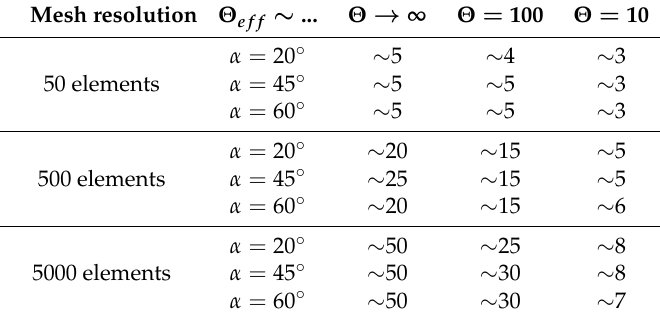
Table 1. Effective diffusion coefficient ratio ( Θ ef f ) for different mesh resolutions, alignment of the magnetic field ( α ) and diffusion coefficient ratios ( Θ ). Mesh resolution Θ ef f ∼